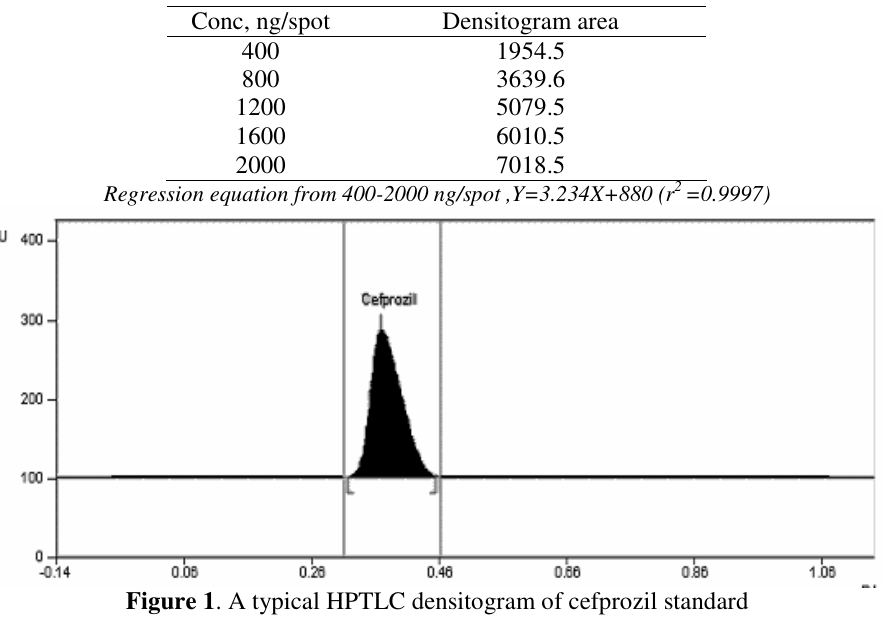
Table 2 . Calibration of the HPTLC method for the estimation of cefprozil